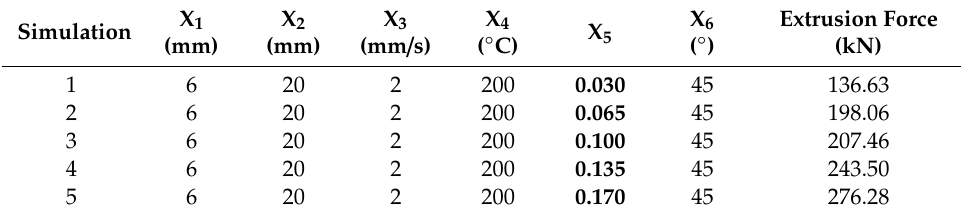
Table 10. Variables combination by varying X 5 (friction coe ffi